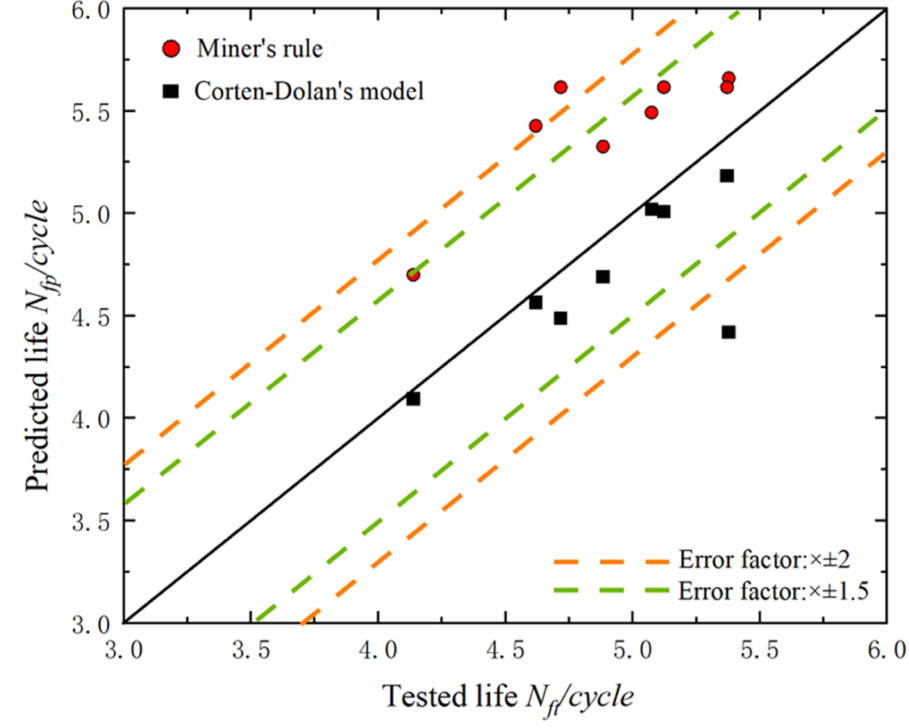
Figure 8. Comparison between fatigue lives predicted using the proposed model, Miner’s rule, and Corten–Dolan’s model, and the fatigue lives tested for M60 high-strength bolts. The fatigue fracture analysis recorded the whole process from the crack initiation to crack expansion and the fracture of the material under cyclic loading. The morphology, color, roughness, and crack propagation path of the fracture are influenced by the stress state, the properties of the testing material, and the environment. Therefore, it is essential to conduct a fatigue fracture analysis to reveal the fatigue damage